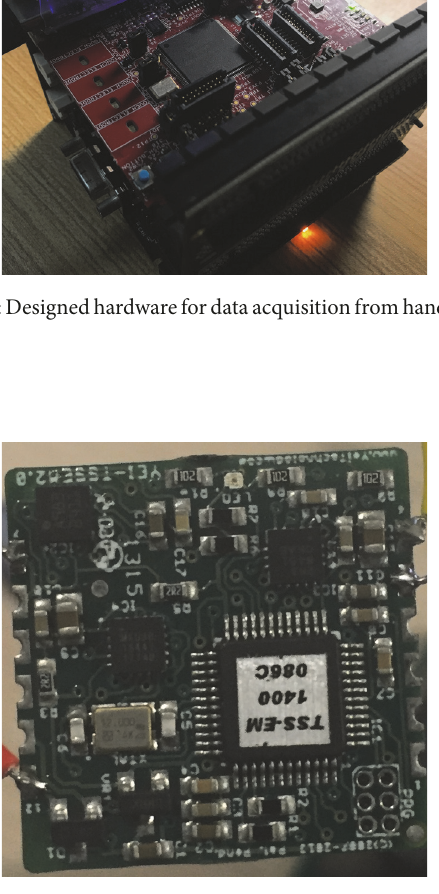
Figure 5: Gesture sensor including 3-axis gyroscope, accelerometer, and magnetometer and reference Euler angles.